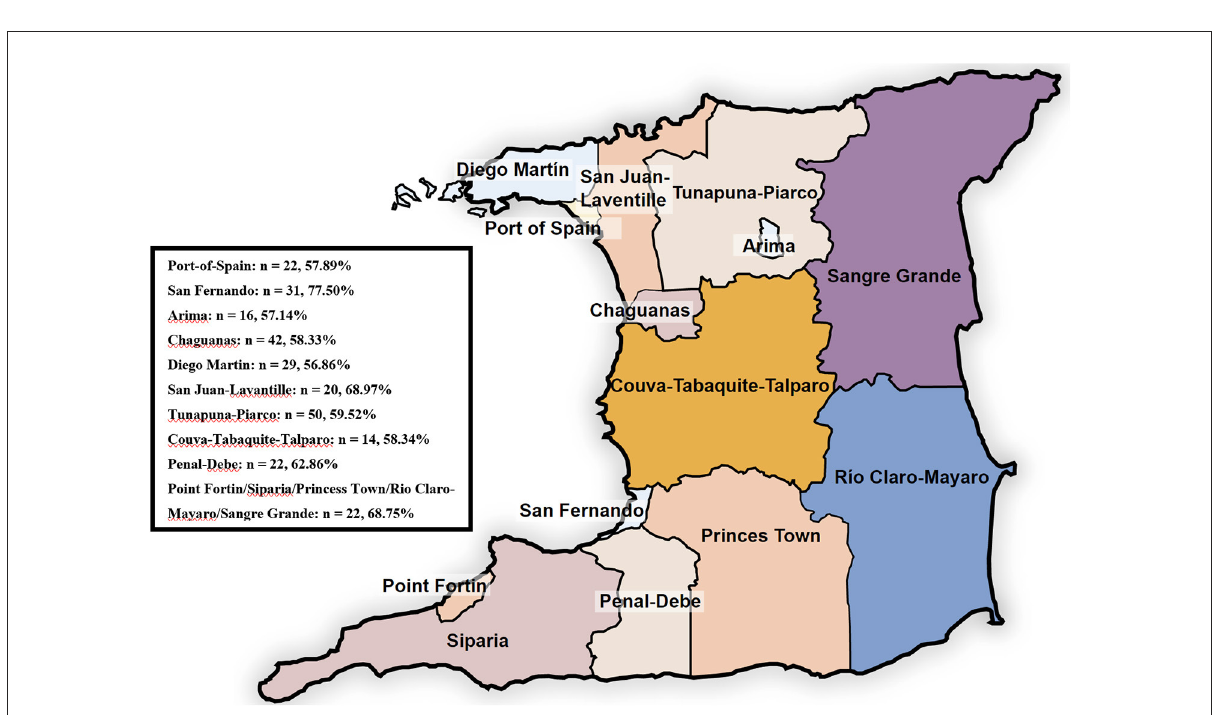
FIGURE3 Prevalence of severe food insecurity by location in Trinidad and